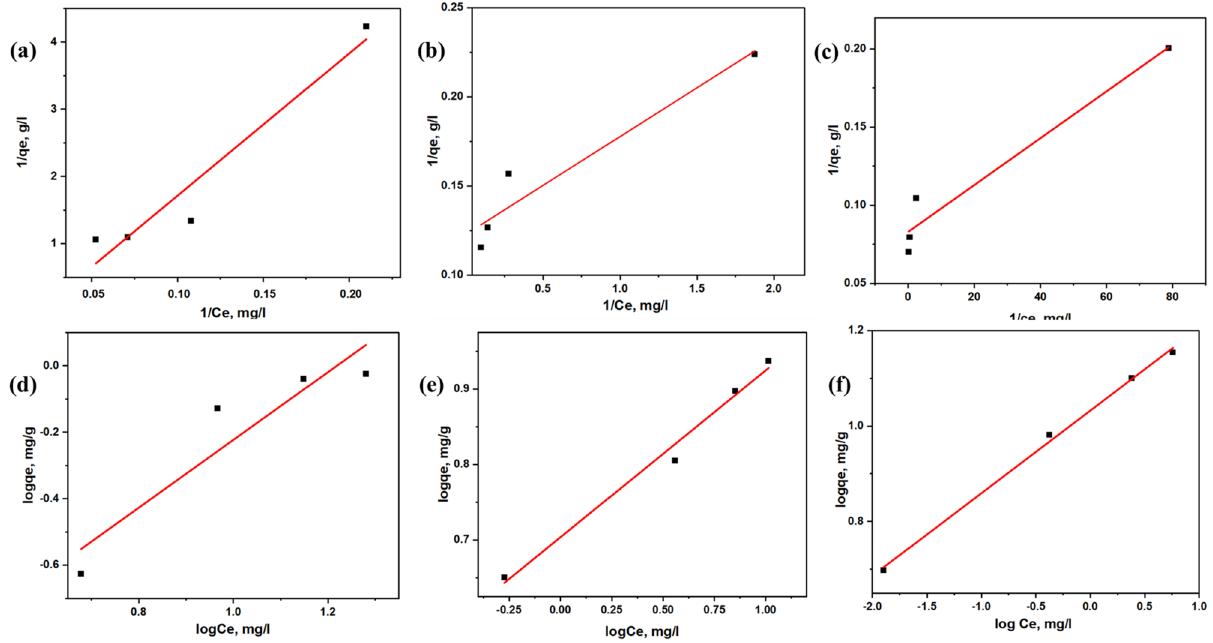
Figure 7. The isotherm models for ( a – c ) Langmuir Isotherm and ( d – f ) Freundlich Isotherms of MNC10, MNC15 and